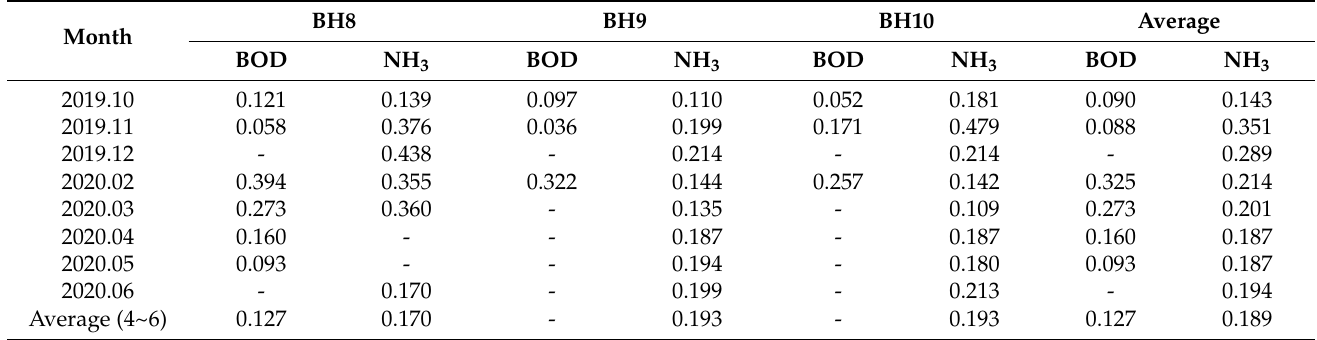
Table 3. BOD decay rates and NH 3 oxidation rates measured in this